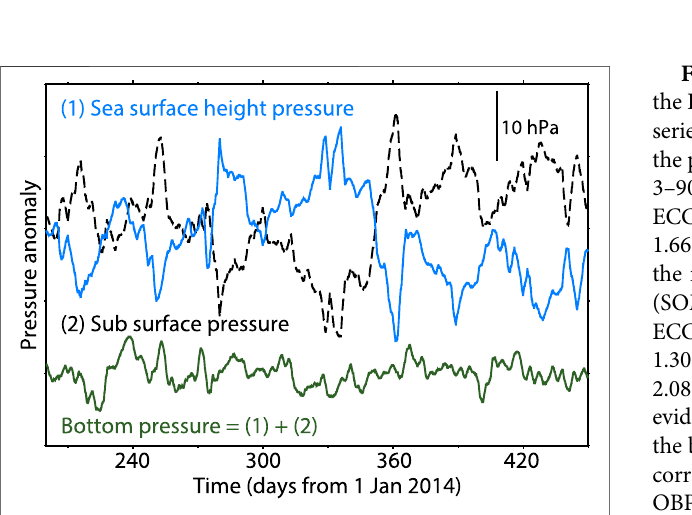
Frontiers in Earth Science |